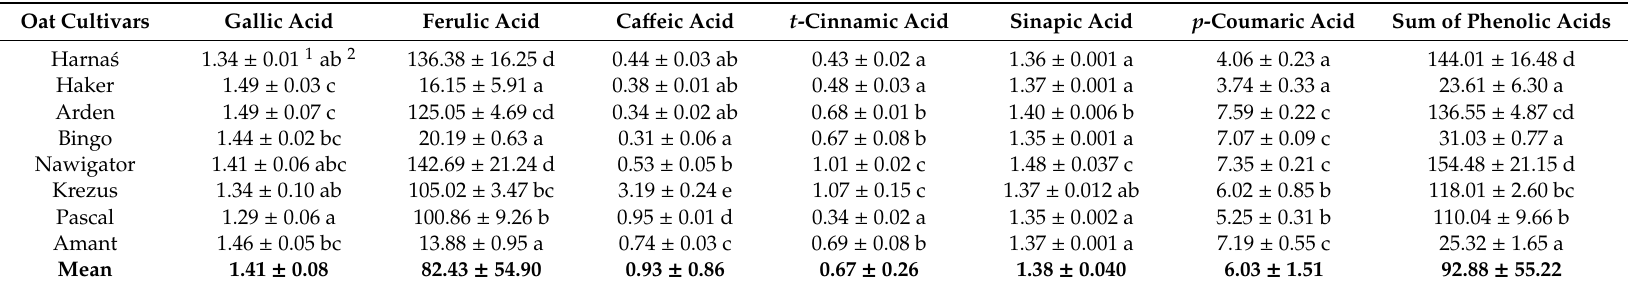
Table 3. Phenolic acids concentrations (mg 100 g − 1 ) in the grain of eight oat cultivars grown organically in the controlled field trial in